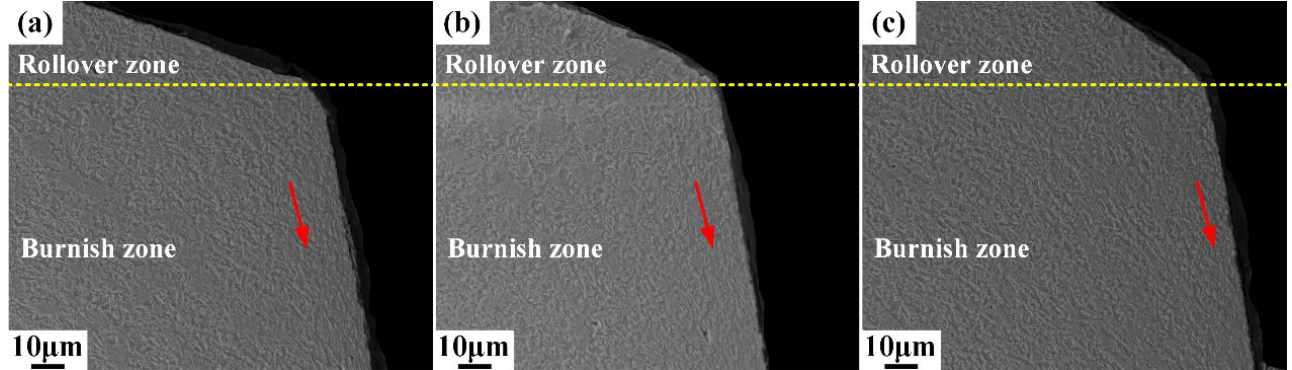
Figure 9. Microstructure of sheared edge in the area I obtained under different shearing clearances: ( a ) 5%t ; ( b ) 10%t ; ( c ) 15%t.